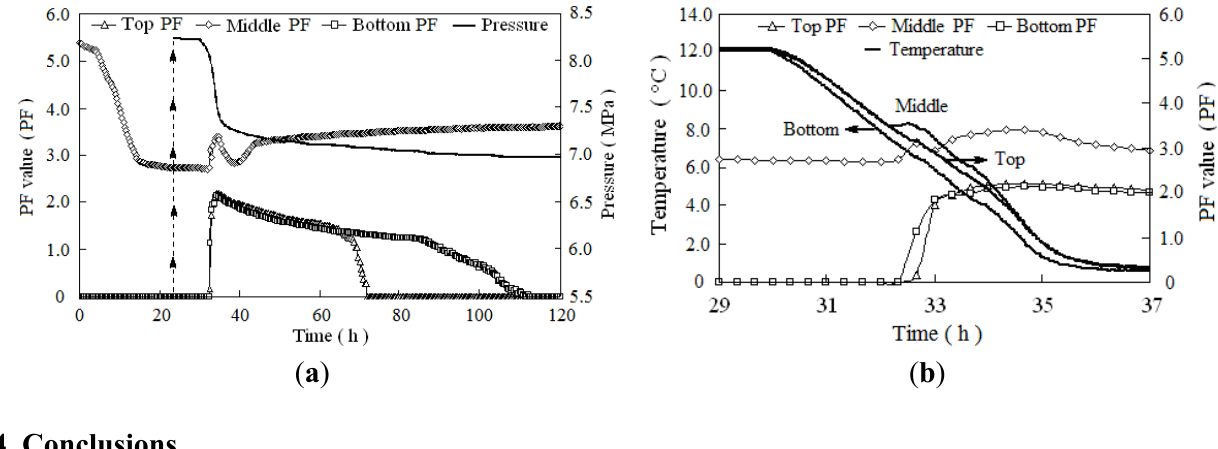
Figure 4. Parameter changes during methane hydrate formation process in the layered medium: top loess layer, middle coarse sand layer and bottom loess layer ( a ) PF value and pressure changes during the whole experiment process; ( b ) Temperature and PF value changes during cooling